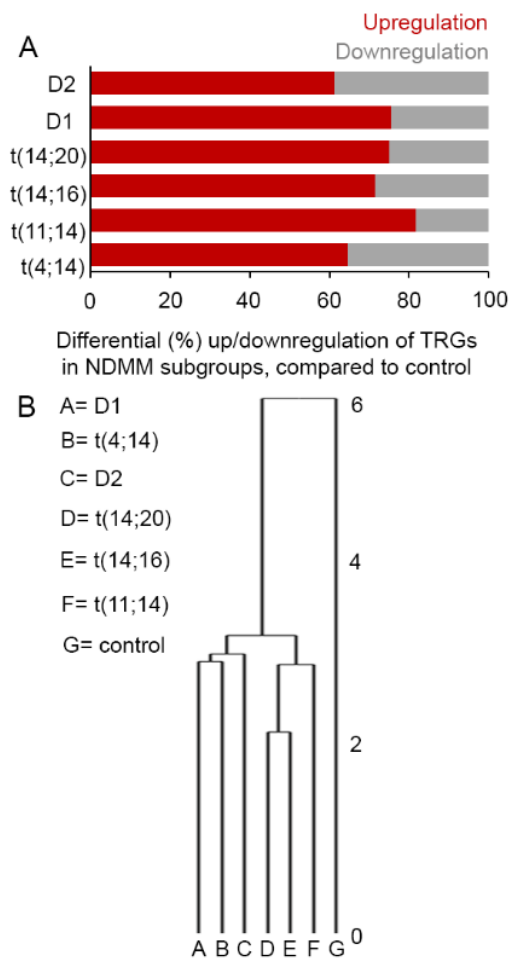
Figure 1. ( A ) A subgroup-specific differential telomere-related genes (TRG)s expression pattern was seen in major molecular subgroups of newly diagnosed multiple myeloma (NDMM) patients compared to controls. ( B ) Unsupervised hierarchical clustering with differentially expressed TRGs showed distinct clustering between D1 and t(4;14) subgroups or MAF subgroups containing t(14;16) or t(14;20) translocations. Abbreviation: NDMM; newly diagnosed multiple myeloma. Next, we narrowed down a panel of TRGs, based on their significant ( p < 0.05) and consistent differential expression across the NDMM subgroups compared to control. For instance, we observed an upregulation of helicase associated DEAD-box helicase 1, DDX1 (mean differential expression [DE] between NDMM subgroups and control, DE: 0.75,